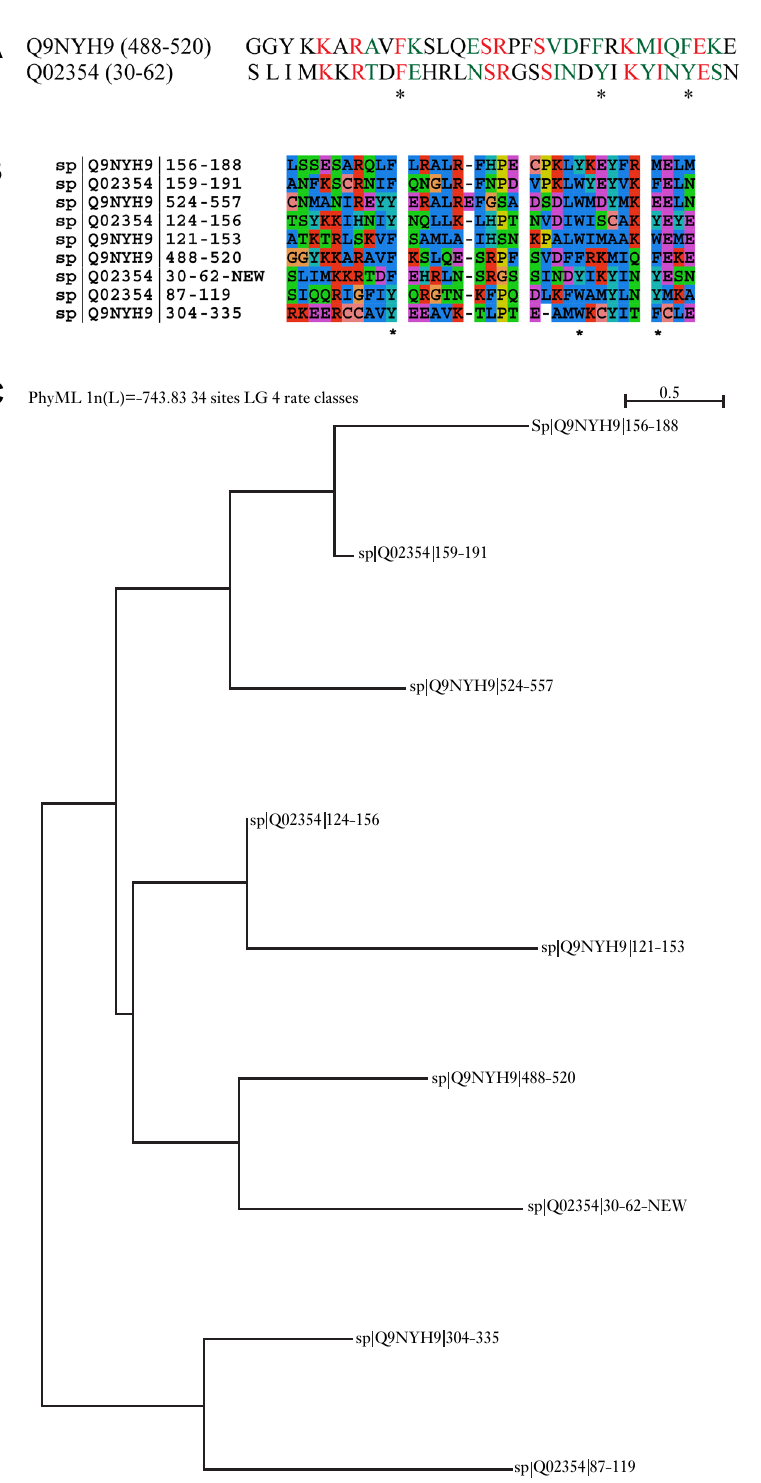
Figure 3. New Half-a-tetratricopeptide (HAT) motif identified by FRAGAL in Saccharomyces cerevisiae . ( a ) Pairwise alignment of a previously unannotated HAT motif in S. cerevisiae (E=11e-4, Z-score=116) (red for identity, green for similarity). ( b ) The multiple alignment for this new sequence (using ClustalW) with other HAT motifs in S. cerevisiae and humans shows large variation amongst HAT sequences even within the same organism. The conserved spacing of the aromatic residues are also highlighted. ( c ) The phylogenetic tree (using PHYML) shows that certain HAT repeats are more similar to HAT repeats from other organisms than to other HAT repeats in its own